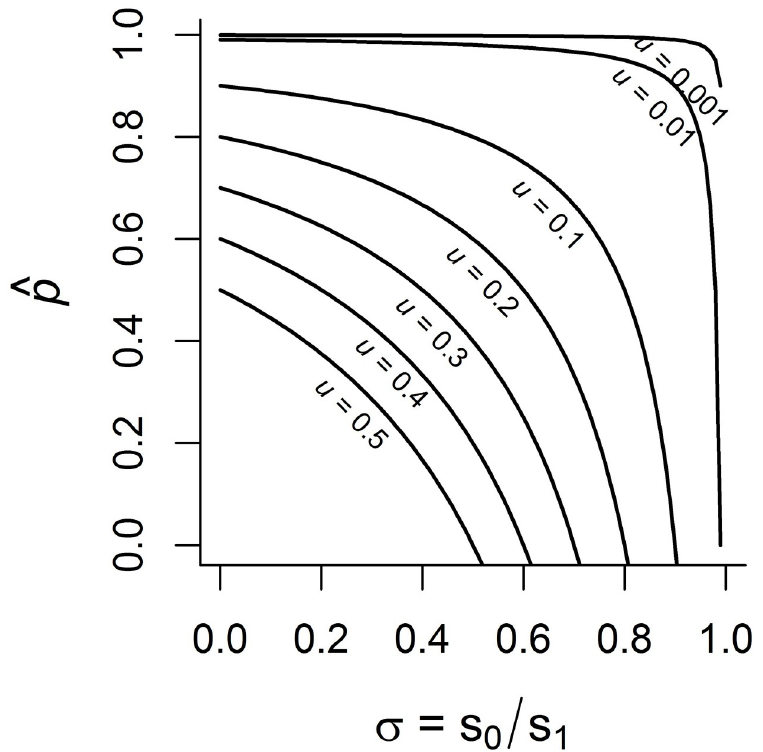
Fig 3. Threshold values as defined by expression 23 for different rates of environmental change u . Areas underneath each curve indicate parameter combinations of ^ p (probability to acquire adaptive behavior) and σ (strength of viability selection) for which older age classes are expected to have larger proportions of adaptive